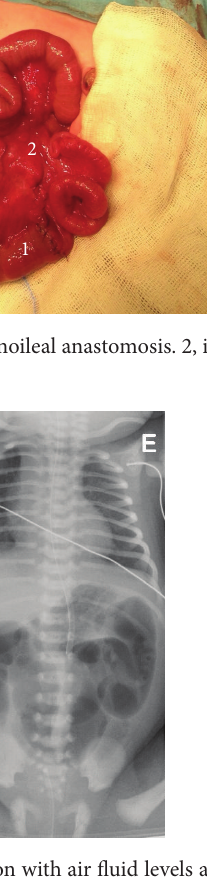
Figure 7: Intestinal distension with air fluid levels and stop sign at the jejunoileal